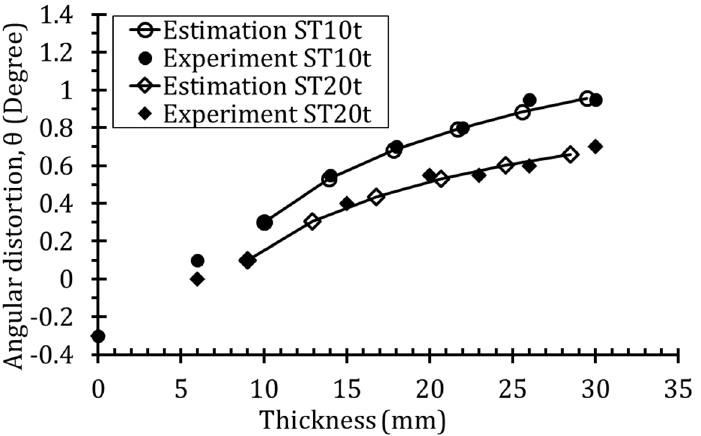
Figure 11. Comparison of experimental and predicted values under constraints for welding conditions of 285 A, 29 V, and 30 cm/min. (ST xx t: strongback with xx mm thickness).